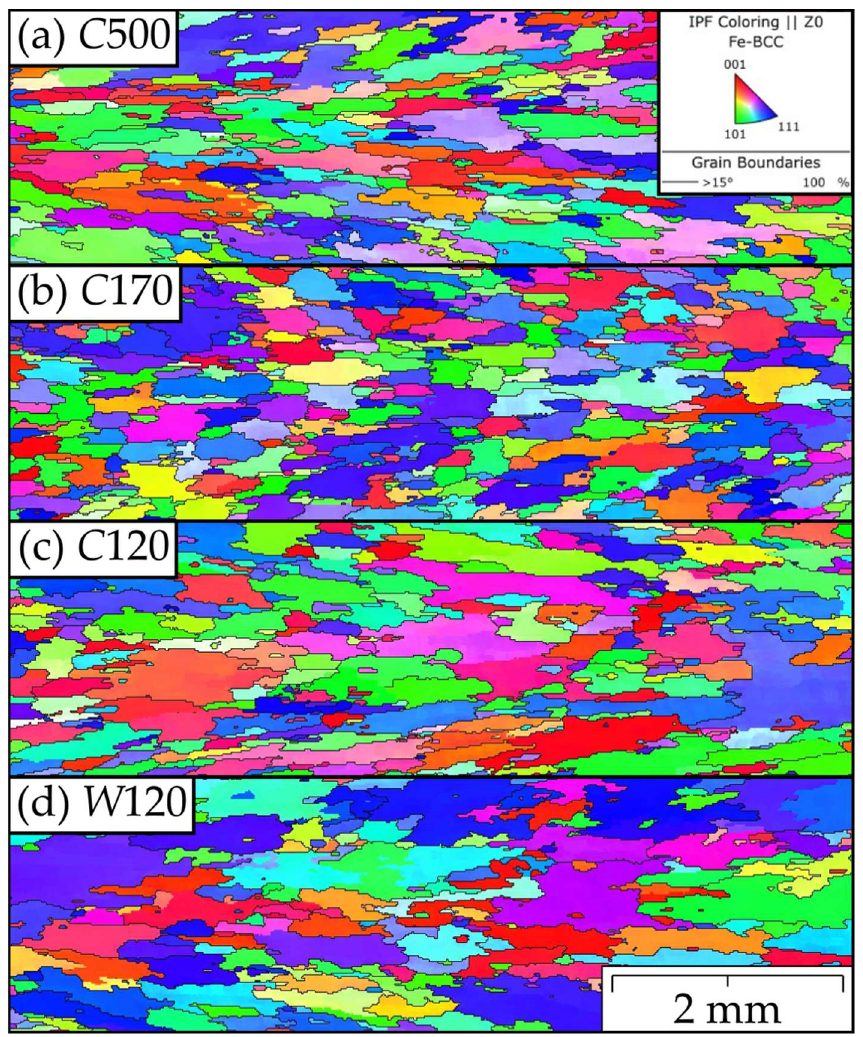
Figure 8. Representative IPF-Z EBSD maps of the favorable coarse-grained microstructures ( a ) C 500, ( b ) C 170, ( c ) C 120, and ( d ) W 120. These specimens are fully recrystallized and elongated in the direction of loading (horizontal direction on the maps). Table 2. Grain size analysis of consolidated recrystallized powders. The batches C 60 and C 90 are not presented, as the recrystallization is incomplete in the specimens.